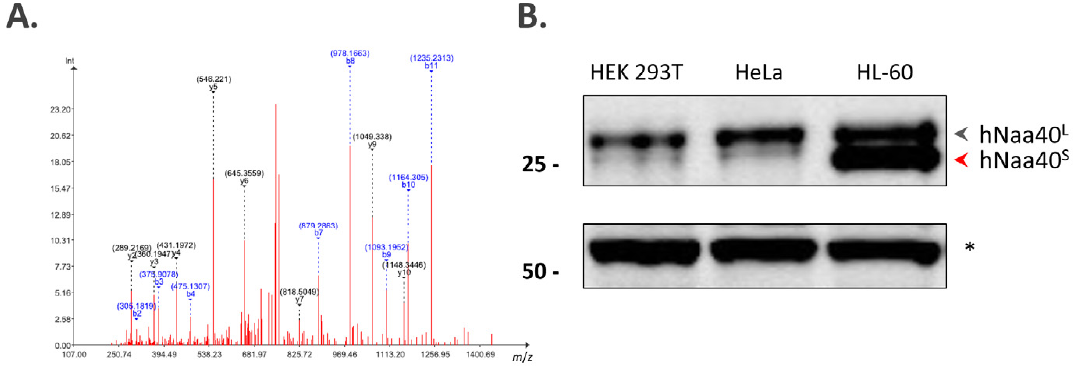
Figure 1. Identification and expression analysis of a novel N-terminally truncated hNaa40p proteoform, hNaa40 S . ( A ) Mass spectrometric (MS) identification of an Nt-truncated Naa40p proteoform (hNaa40 S ) raised upon translation initiation at a downstream translation initiation start site (dTIS) as demonstrated by the MS 2 -based identification of the Nt-acetylated peptide MDAVCAKVDAANR (orange) matching amino acid sequence positions 22 to 34 of full-length canonical hNaa40 L (Q86UY6, length: 237 AA). The MS 2 spectrum matches a doubly charged precursor mass of m / z 762.3546, corresponding to the modified peptide sequence Ac-M < Mox > DAVC < Cmm > AK < AcD3 > VDAANR, and with ‘Ac-’, ‘Cmm’ and ‘AcD3’ denoting an acetyl, carbamidomethyl and (trideutero)acetyl moiety [21]. Tryptic peptide identifications reported in ProteomicsDB ([22], accessed January 2021) are indicated in bold in the hNaa40 L protein sequence overall providing a sequence coverage of 80.17% and with the reported AAMDAVCAK peptide indicative of hNaa40 L expression (Figure S1) ( B ) Expression profiling of endogenous hNaa40p in different human cell lines by Western blot analysis indicates expression of hNaa40 L in all 3 cell lines and prominent expression of the short proteoform of hNaa40p (hNaa40 S ) in the pro-myelocytic leukemia cell lines HL-60. A non-specific band (*) serves as loading